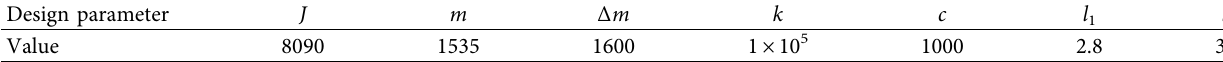
Table 1: Initial design parameters of the KLK2 high-speed elevator.